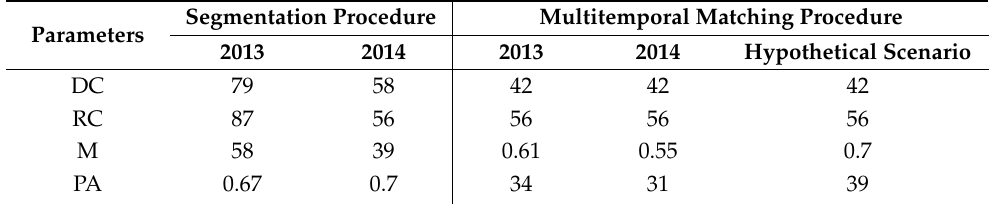
Table 2. The accuracy assessment of the single-tree segmentation procedure (on the left) and the multitemporal matching procedure (on the right). M = Matched Crowns; RC = Reference Crowns; PA = Producer Accuracy; DC = Defined Crowns; UA = User Accuracy. Segmentation Procedure Parameters